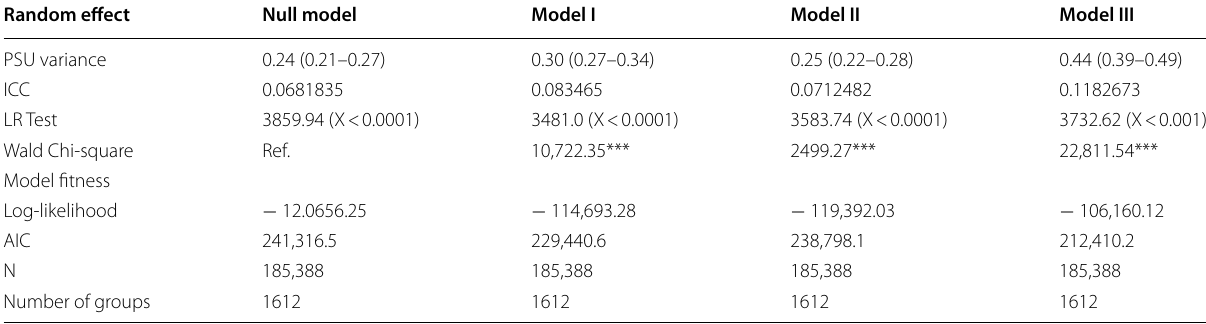
Table 4 Random effects (measures of variations) results on the factors associated with obstetric fistula awareness among women in sub‑Saharan